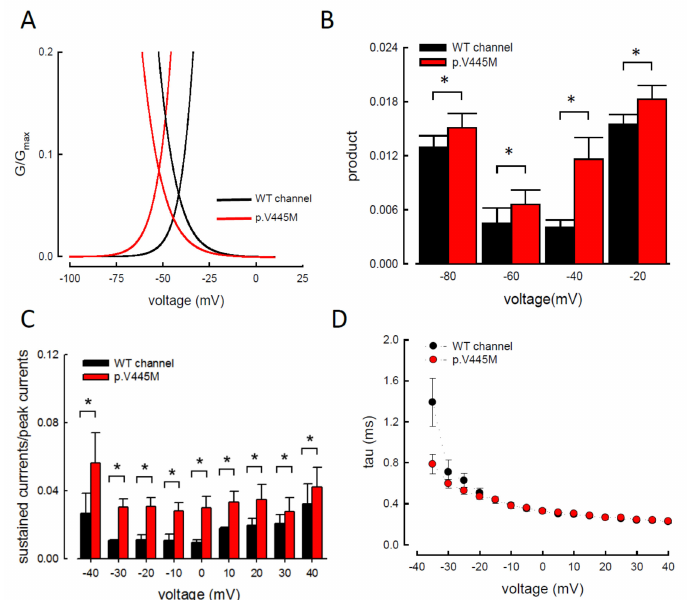
Figure 3. Larger window currents in the p.V445M mutant channel in the Chinese hamster ovary (CHO-K1) cells ( A ) An enlarger view of Figure 2B between − 100 and + 5 mV. ( B ) The product of G / G max and I / I max at each voltage from Figure 1B is plotted against the di ff erent voltages in the WT and p.V445M mutant channels (*, p < 0.05 compared to the WT). ( C ) The ratio between the sustained (the average currents between 90 and 95 ms of the pulse) and peak (maximal) transient currents at + 40 to − 40 mV (sample sweeps in Supplementary data Figure S2) is significantly smaller in the WT channels in comparison with the p.V445M mutant channels (*, p < 0.05 between the WT and p.V445M mutant channel). ( D ) Fast-inactivation kinetics of WT and p.V445M mutant channels. The inactivation time constants were obtained by fitting the decay phase of transient sodium currents (Na T ) shown in Figure 2A with a mono-exponential function. Data are expressed as means ±